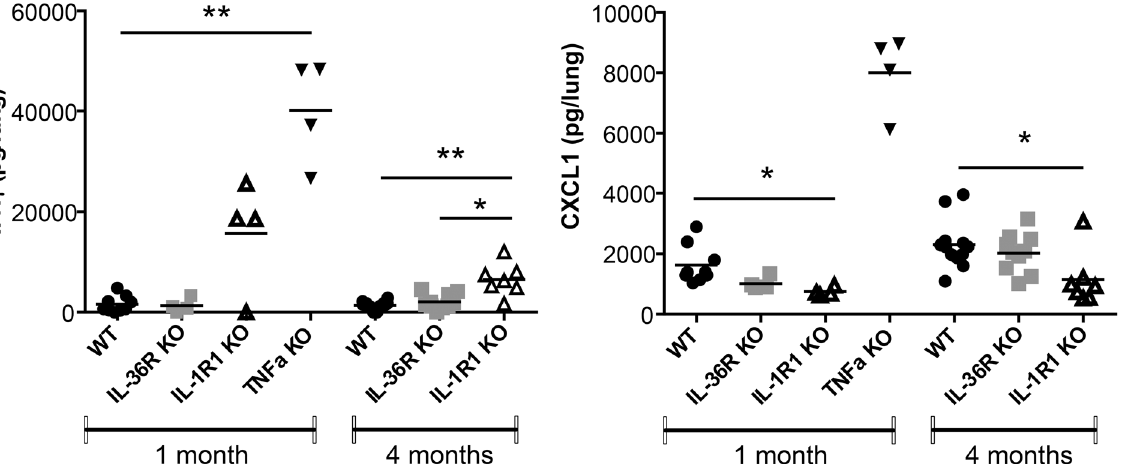
Fig 10. Lung IFN- γ and Cxcl-1 levels in M . tuberculosis infection. The levels of IFN- γ and Cxcl-1 protein were determined in lung homogenates 1 month post aerogenic M . tuberculosis infection in TNF- α deficient, IL-36R deficient, IL-1R1 deficient, and wild-type mice, and 4 months post-infection in